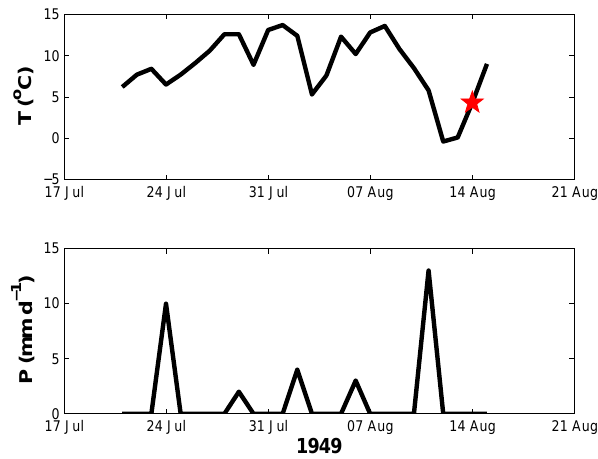
Fig. 16. Temperature and precipitation in summer 1949 at the Col du Grand Saint Bernard (2472m a.s.l.), located about 20km west of the Glacier du Tour. The break-off is indicated by a red star.